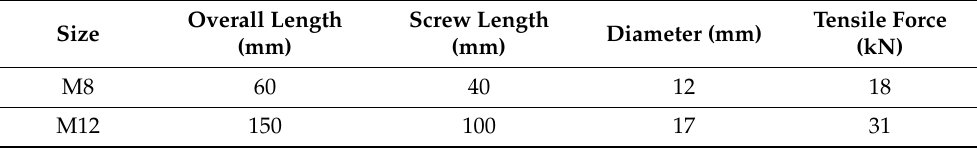
Figure 3. Description of the RTU systems on the shaking table. Table 3. Description of the set anchors M8 and